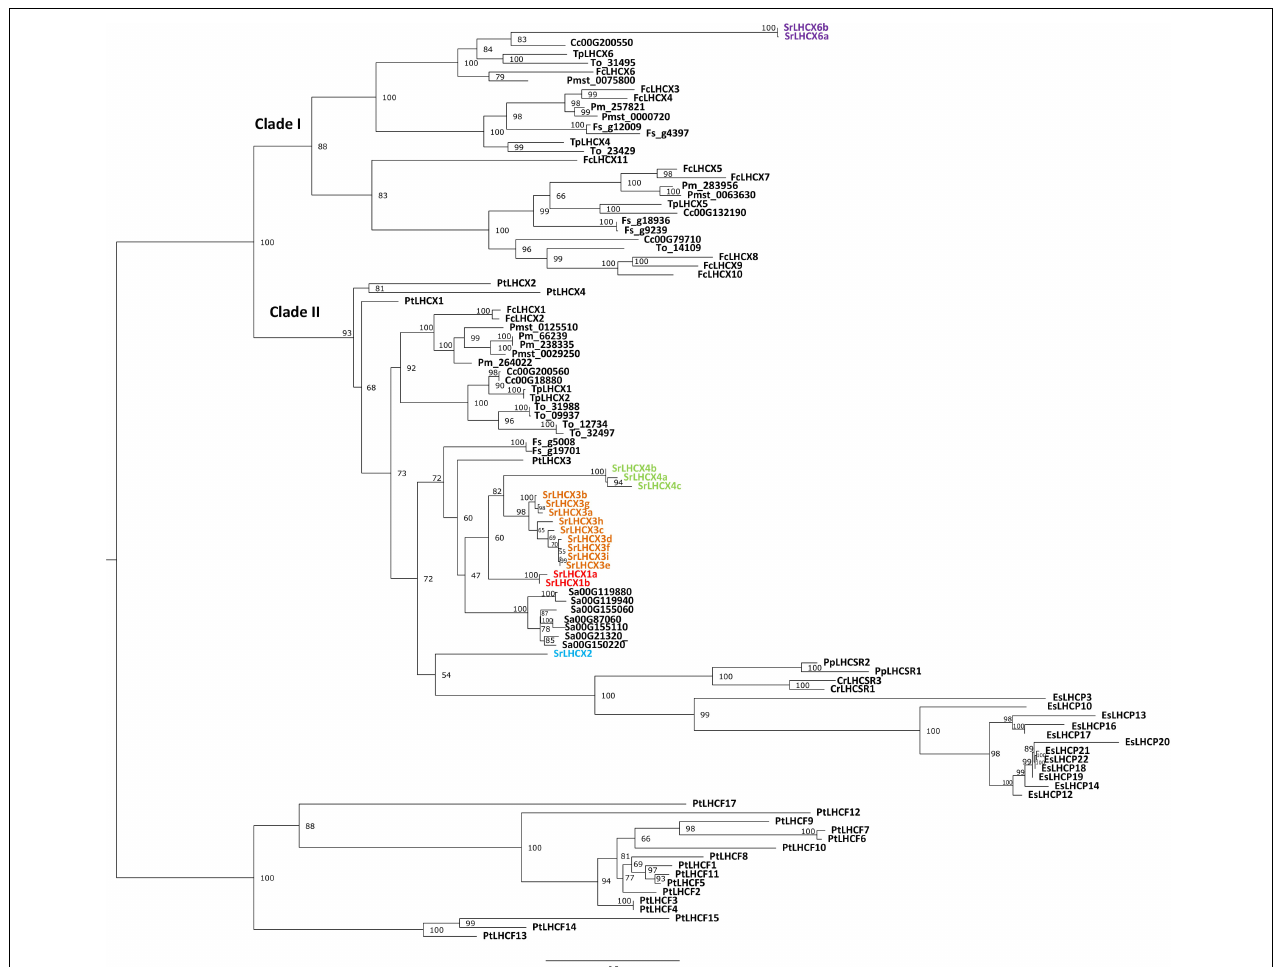
FIGURE 1 | Phylogenetic tree of LHCX genes in Seminavis robusta (Sr, colored), based on a multiple alignment made using MAFFT L-INS-i and constructed using IQ-tree. Total of 10,000 ultra-fast bootstrap approximation iterations were run (values are shown at the nodes). LHCX/LHCSR sequences are shown for the diatoms Thalassiosira pseudonana (Tp), Thalassiosira oceanica (To), Cyclotella cryptica (Cc), Phaeodactylum tricornutum (Pt), Fragilariopsis cylindrus (Fc), Fistulifera solaris (Fs), Synedra acus (Sa), Pseudo-nitzschia multistriata (Pmst) and Pseudo-nitzschia multiseries (Pm, with kind permission of E. V. Armbrust), the green alga Chlamydomonas reinhardtii (Cr), the moss Physcomitrella patens (Pp) and the brown alga Ectocarpus siliculosus